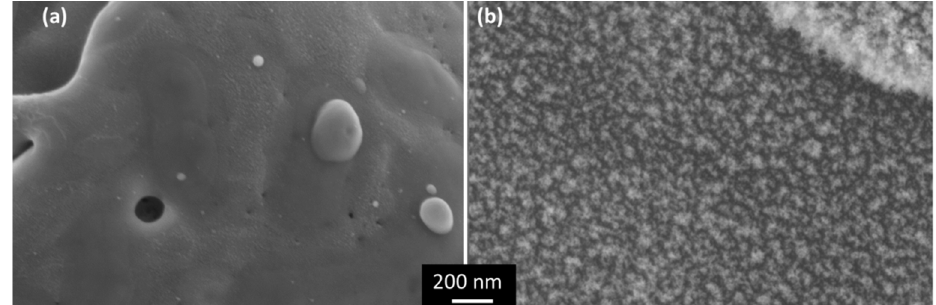
Figure 5. SEM images (Inlens detector) of copper surfaces processed with ( a ) LSM, ( b ) bit-map method, just after laser processing. The same magnification was used in both images.